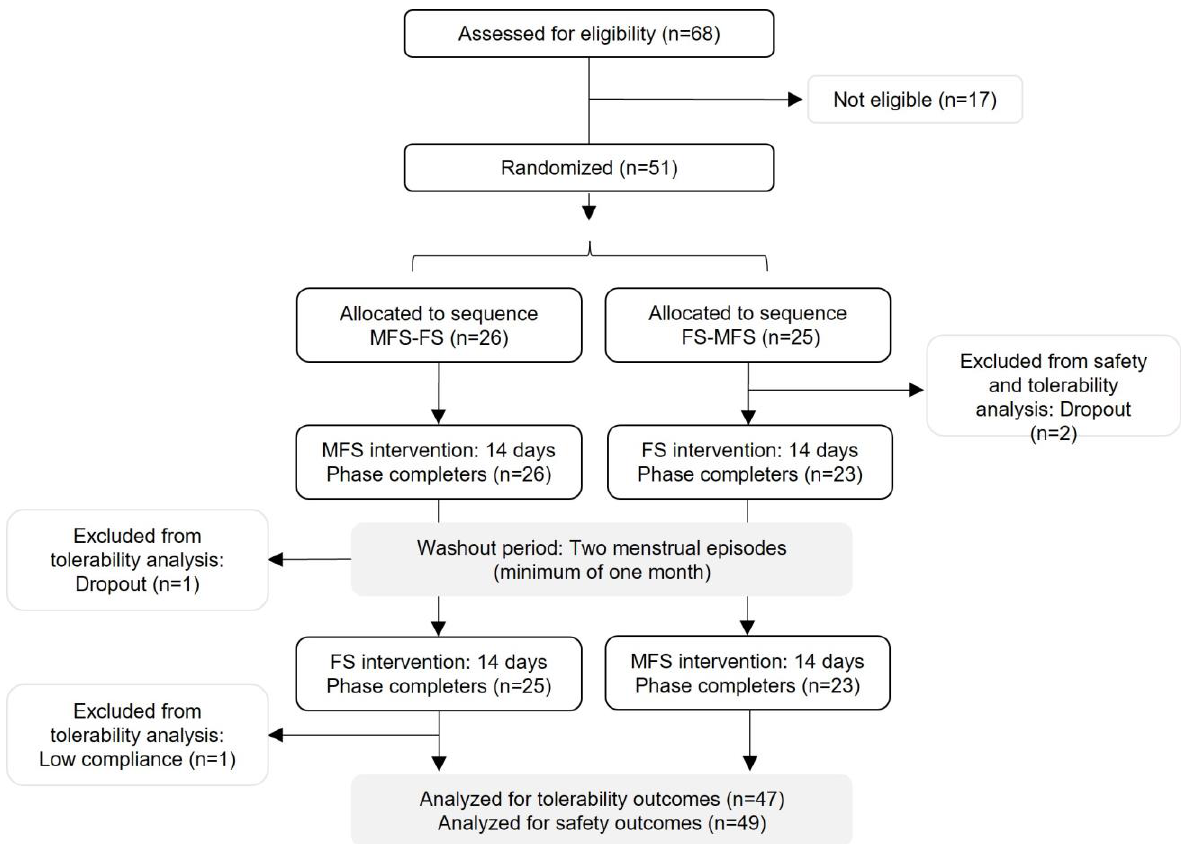
Figure 1. Flow chart of the study population (MFS: microencapsulated ferric saccharate, FS: ferrous sulphate). Table 1. Demographics and baseline characteristics of participants.